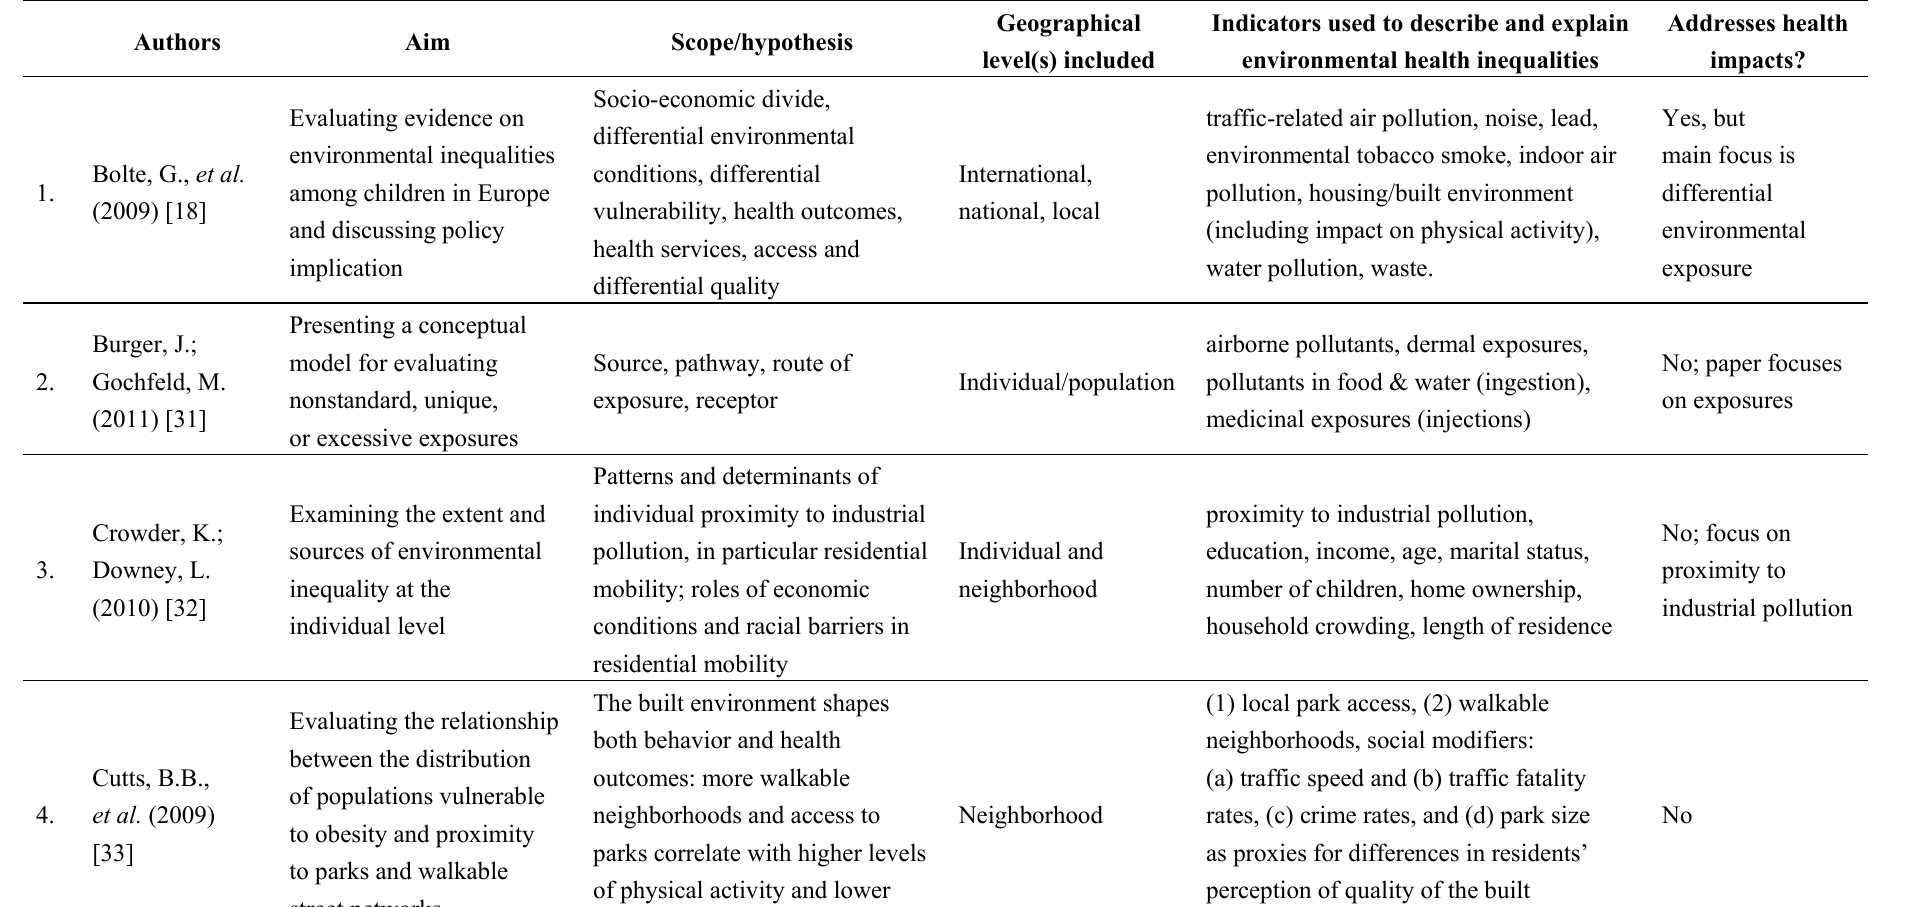
Table 2. Characteristics of the selected environmental justice